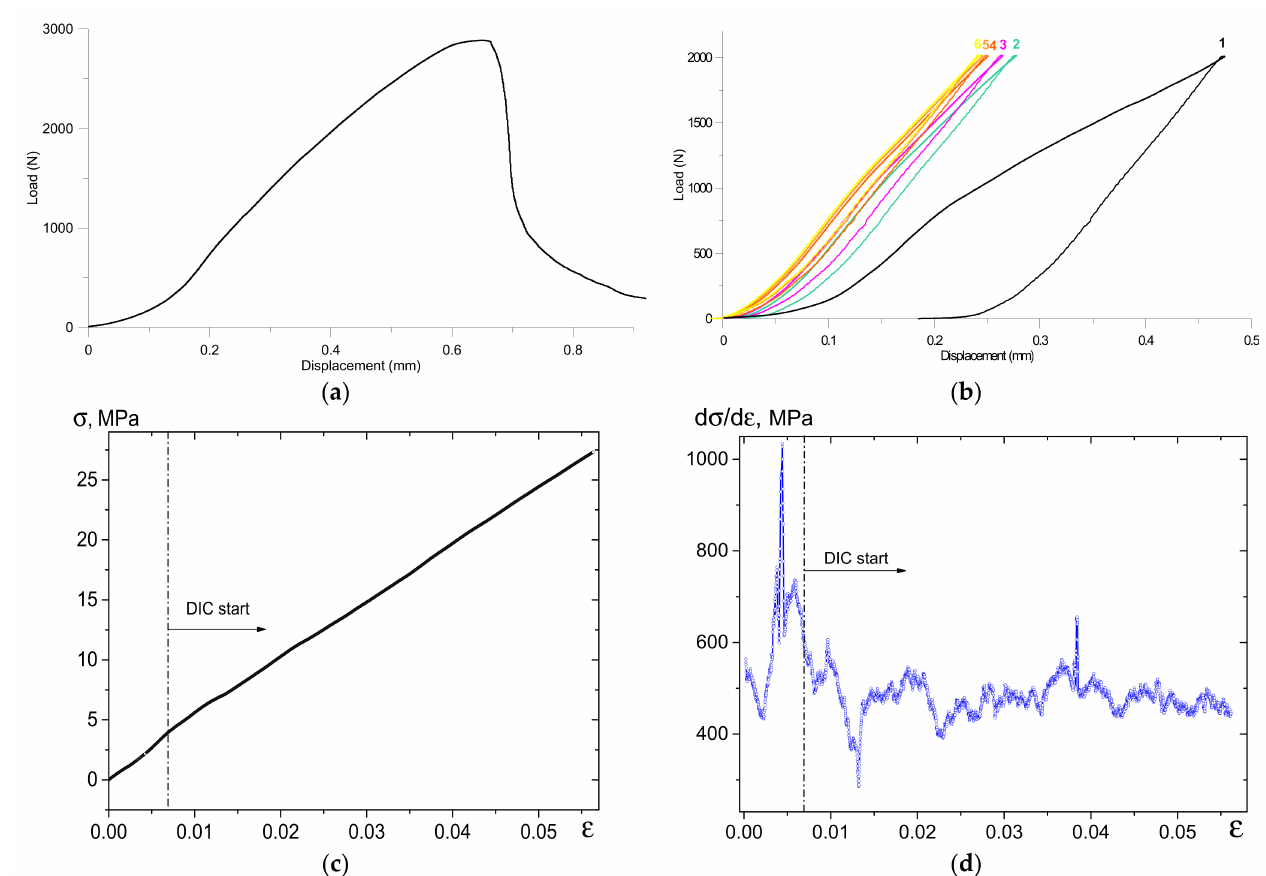
Figure 3. The monotonic compression load–displacement curve ( a ); cyclic loading ( b ); stress–strain diagram below the 0.8UCS ( c ); and the behavior of the d σ –d ε curve below 0.8UCS ( d